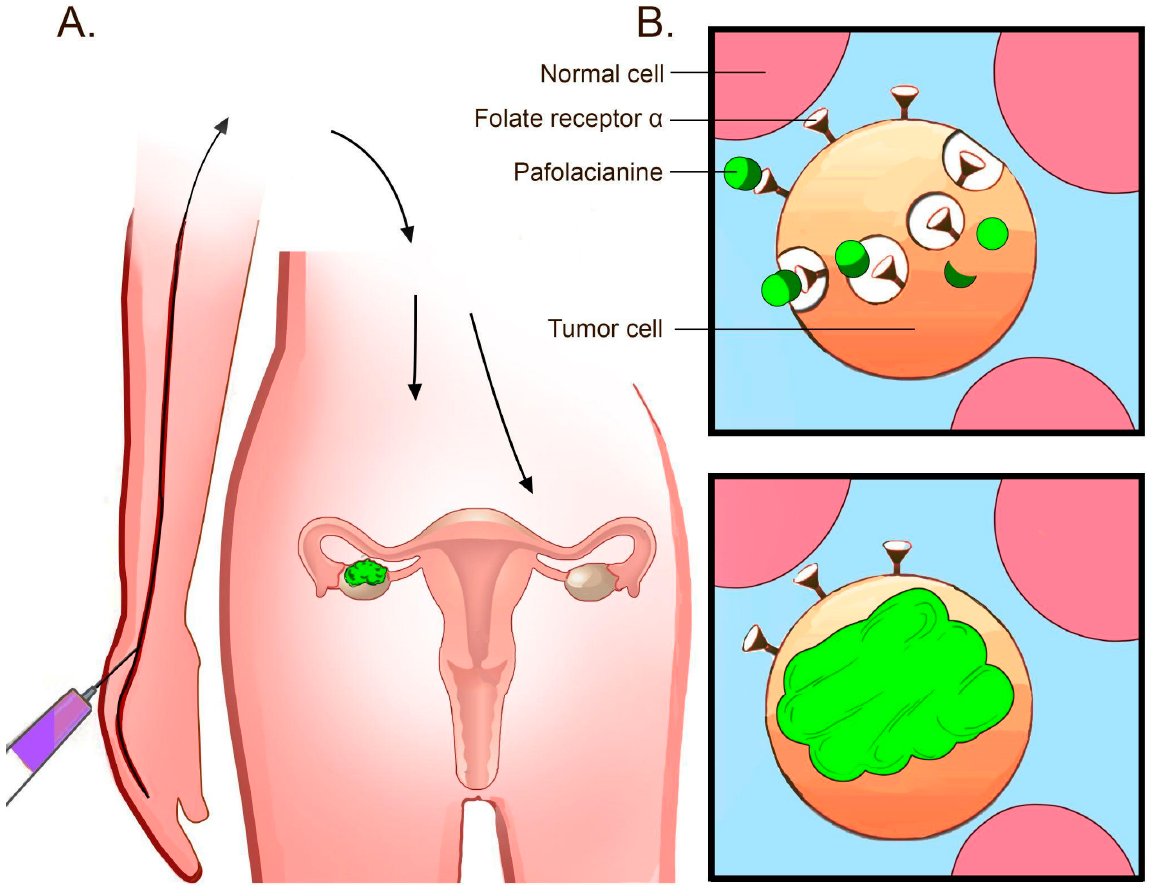
Figure 2. Mechanism of the pafolacianine-based intraoperative detection of tumors. ( A ) Pafolacianine is intravenously administered within a couple of hours before the surgery. As the agent circulates through the blood flow, only the tissues that overexpress FR α capture the dye. FR α upregulation in ovarian cancer lesions enables the binding of pafolacianine and near-infrared fluorescence imaging during surgery. ( B ) Pafolacianine binds FR α overexpressed in ovarian cancer tumors. The dye accumulates in the cells via endocytosis [6].